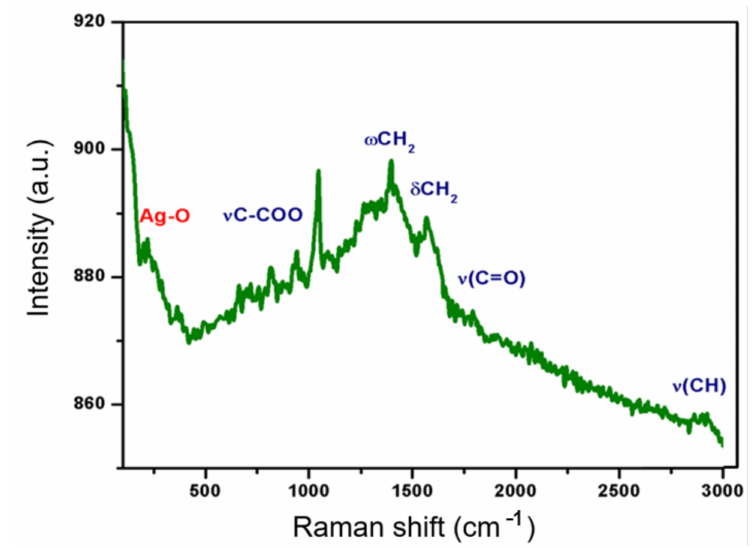
Figure 2. Raman spectrum obtained from PCL/Ag